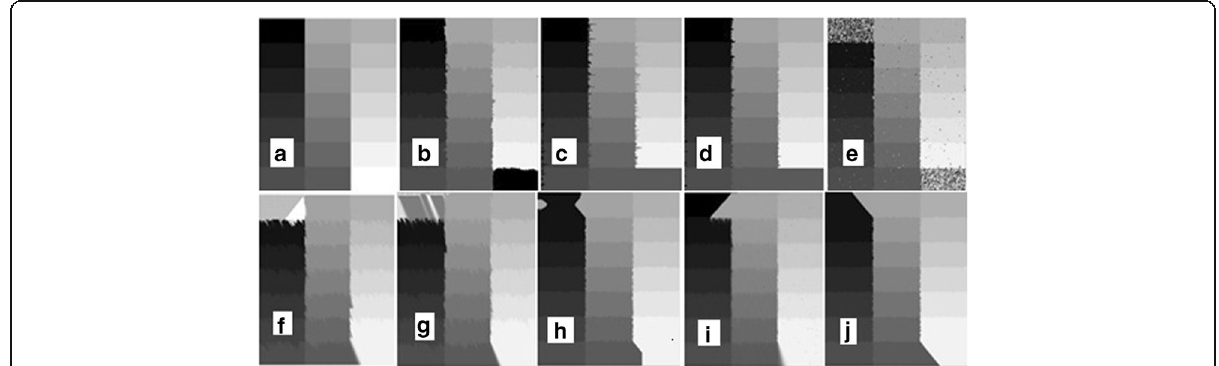
Fig. 11 Performance of various algorithms corrupted by 90% salt and pepper noise on synthetic image a original image, b AMF (W max = 39), c DBA, d IDBA, e NAFSM, f MDBUTMF, g MDBUTMF-GM, h ACBSA, i AWMF (WMAX = 39), and j